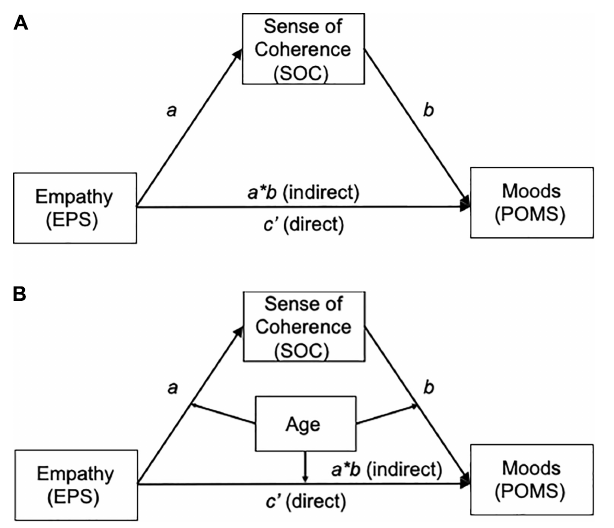
FIGURE 1 | (A) Schematic model of sense of coherence (SOC) as a mediator between empathy (EPS) and self-moods (POMS): the proposed Model 4 adapted from Hayes (2018). X, independent variable; Y, dependent variable; M, mediator. The path a , X (EPS) to M (SOC); the path b , from M (SOC) to Y (POMS). The path c’ means the “direct” effect of X (EPS) on Y (POMS) and the path a*b means “indirect” effect of X on Y through M. The total effect of X (EPS) on Y (POMS) means the sum of the direct effect ( c’ ) and the indirect effect ( a*b ). EPS, empathy process scale; SOC, sense of coherence; POMS, profile of mood state. (B) Schematic model of age as a moderator of the mediation model: the proposed Model 59 adapted from Hayes (2018). X, independent variable; Y, dependent variable; M, mediator; Mo, moderator. The path a , X (EPS) to M (SOC); the path b , from M (SOC) to Y (POMS). The path c’ means the “direct” effect of X (EPS) on Y (POMS) and the path a*b means “indirect” effect of X on Y through M. The total effect of X (EPS) on Y (POMS) means the sum of the direct effect ( c’ ) and the indirect effect ( a*b ). All pathways are moderated by Mo (age). EPS; Empathy process scale; SOC: Sense of coherence; POMS: Profile of mood